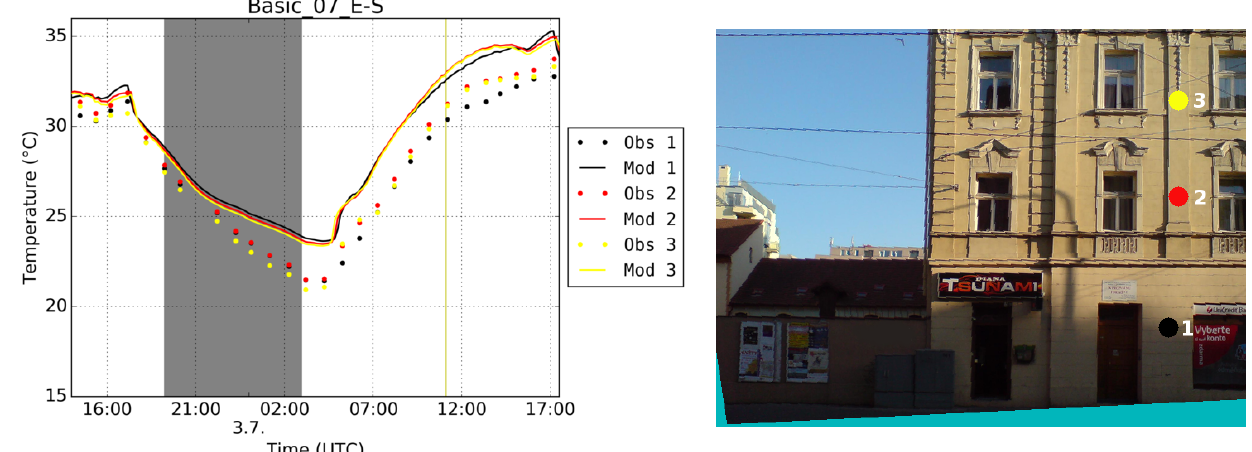
Figure 11. As for Fig. 9 for location 7 (50.10329 ◦ N, 14.45040 ◦ E) – view of the north-facing wall.